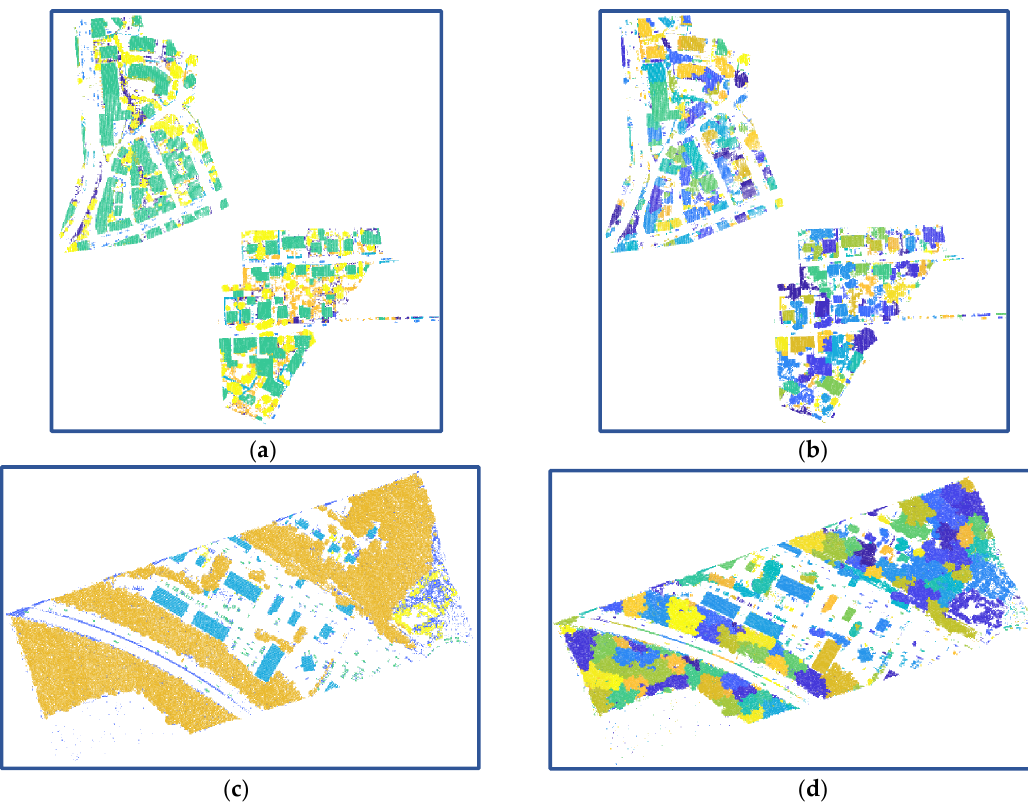
Figure 10. Filtered and clustering results of off-ground points from two ALS datasets: ( a ) off-ground points of Vaihingen Dataset obtained with Algorithm 1; ( b ) clusters of (a) obtained with Algorithm 2; ( c ) off-ground points of GML Dataset A obtained with Algorithm 1; ( d ) clusters of ( c ) obtained with Algorithm 2.